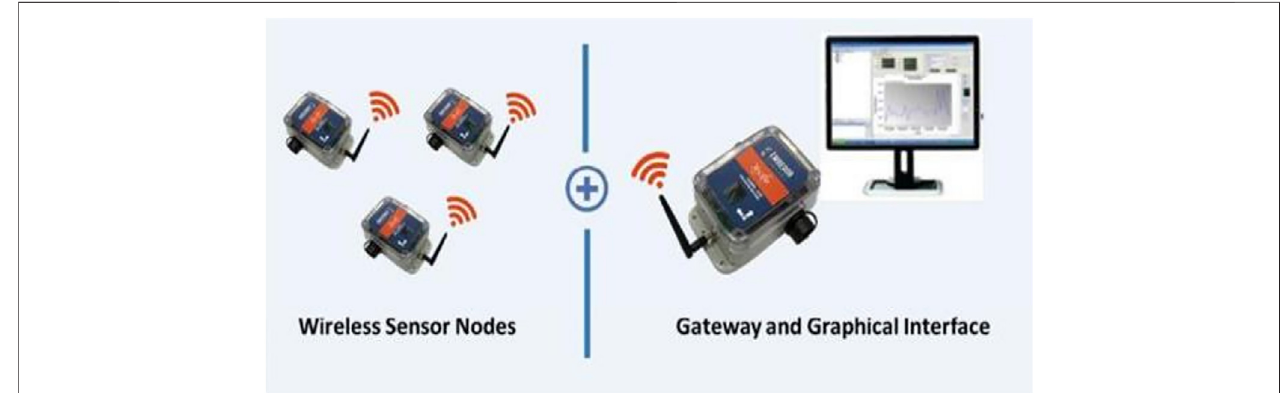
FIGURE 4 | Xnode wireless sensor.